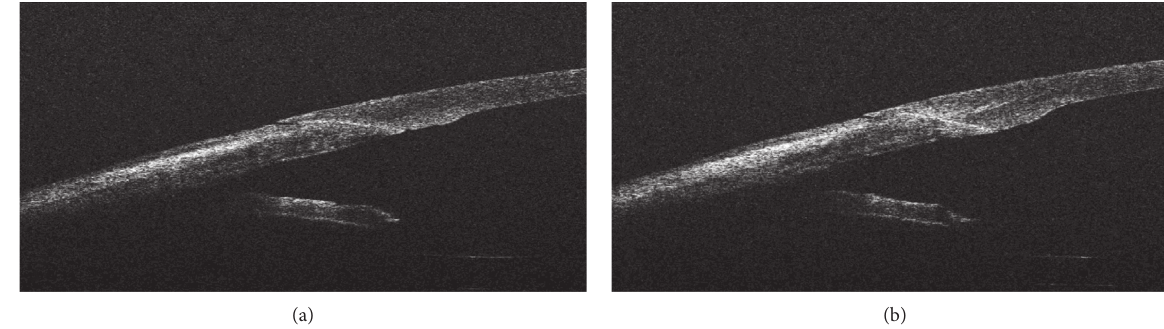
Figure 2: Well-adapted corneal incision before hydration (a); lateral stromal hydration had no effect on corneal incision architecture (b).